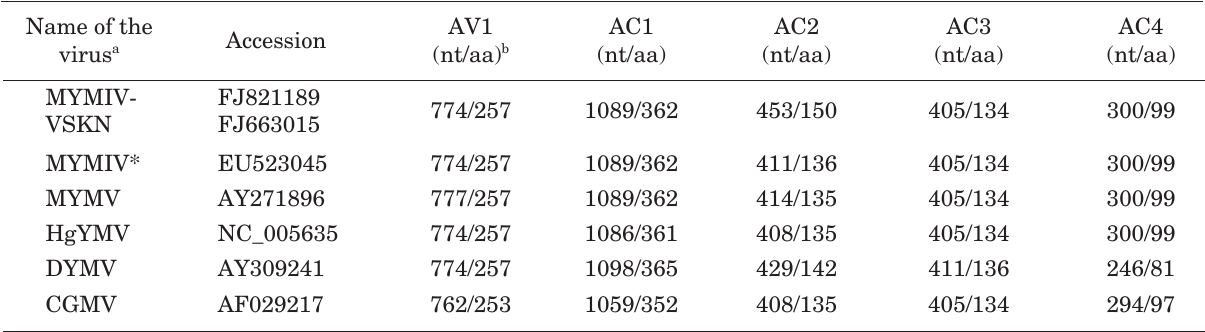
Table 1. Details of viruses and their genes used for comparison of sequence